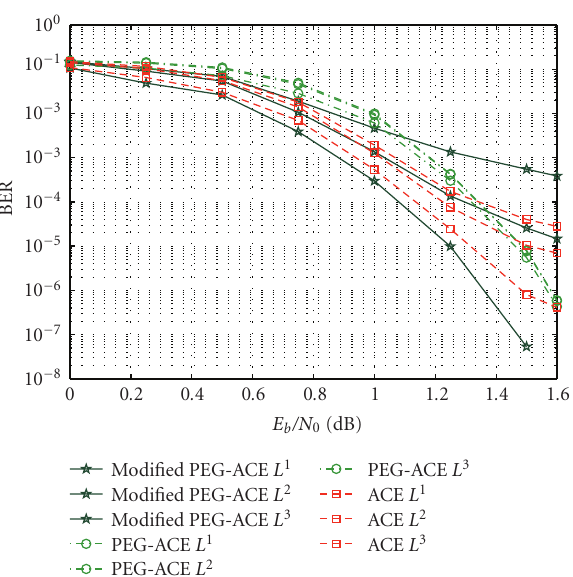
Figure 9: BER of the modified PEG-ACE code in comparison to the original PEG-ACE code and the ACE